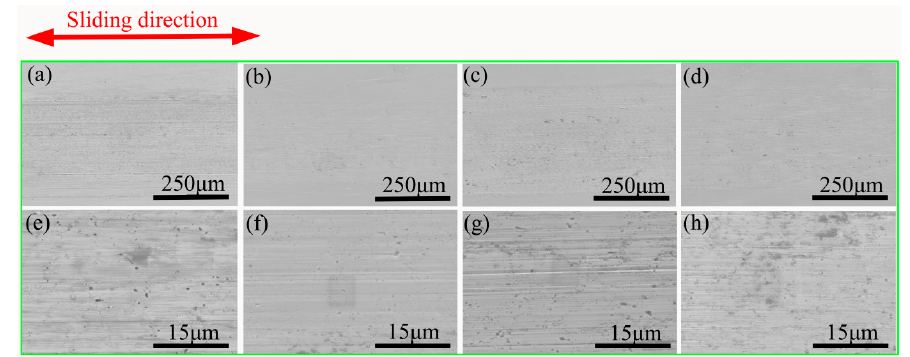
( b , f ) 5 wt.% HEA; ( c , g ) 10 wt.% HEA; and, ( d , h ) 15 wt.% HEA, respectively. Materials 2018 , 11 , x FOR PEER REVIEW